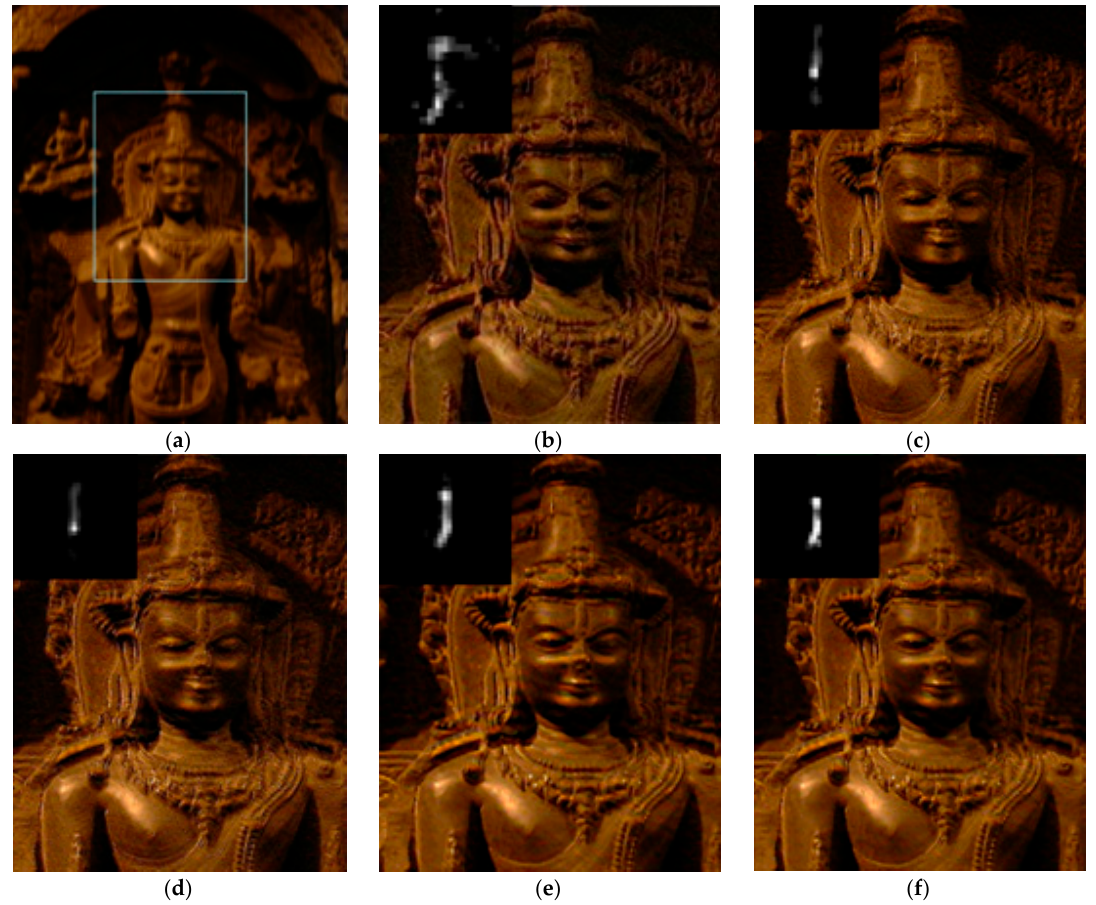
Figure 10. Comparison of different restoration algorithms on the Buddha image. ( a ) Real blurred image, ( b - f ) are the restored results of the region in the box in ( a ); ( b ) result of Fergus et al. [3]; ( c ) result of Shan et al. [4]; ( d ) result of Cho and Lee [6]; ( e ) result of Xu and Jia [7]; and ( f ) result of our algorithm.